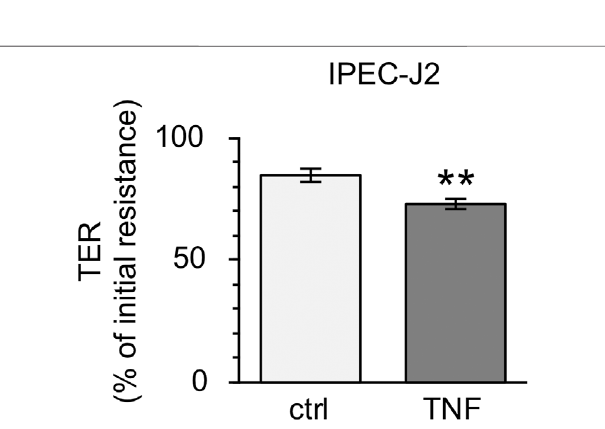
FIGURE 7 | Densitometry (A) and representative Western blot bands (B) of TNFR-1 and -2 after 10 h incubation of PP FAE and VE tissue in the Ussing chamber with or without TNF. The expression of TNFR-2 increased in PP FAE tissue specimens after incubation with the cytokine, whereas the expression of TNFR-1 was not signi fi cantlyaltered( n =4 – 7,*** p < 0.001).InVEsamples,neitherofthetworeceptorsshowedsigni fi cantchangesafterexposuretoTNF( n =6 – 7).Thecontrolswereset to 100% and are depicted by the dotted line.